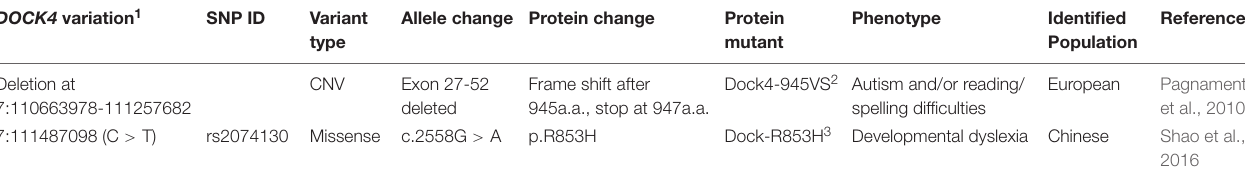
TABLE 1 | DOCK4 variations associated with autism spectrum disorder and Dyslexia.